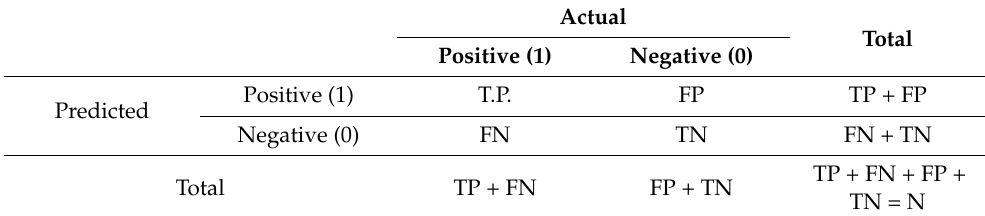
Table 3. Confusion